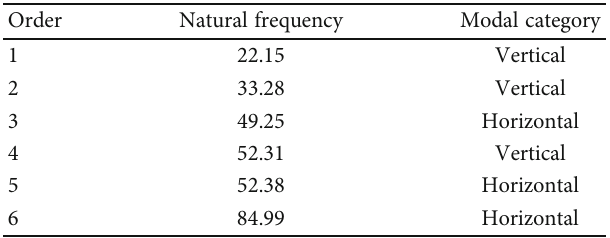
Table 4: Natural frequencies of the elastic tube